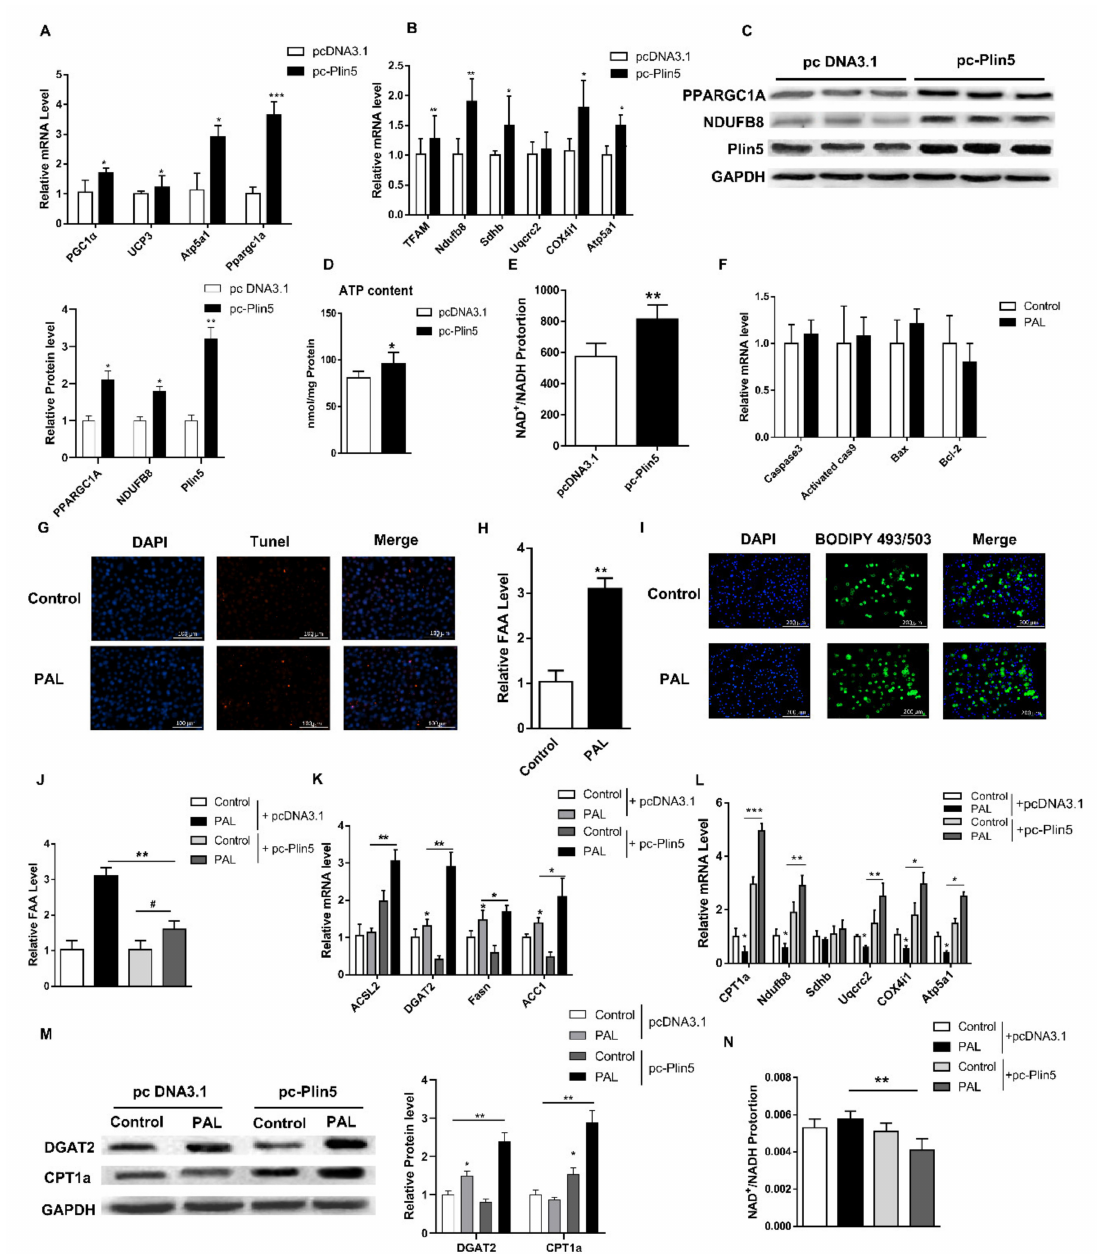
Figure 6. Plin5 promotes lipid synthesis and enhances mitochondrial β -oxidation in a lipotoxic model. ( A , B ) Real-time quantitative PCR was used to detect mitochondrial functional gene and β -oxidation gene mRNA expression after Plin5 overexpression. ( C ) Under the same treatment as ( A , B ), the protein levels of differentially expressed genes were analyzed by Western blotting. ( D ) The kit detected the ATP content of porcine adipocytes transfected with Plin5 overexpression vector. ( E ) The ratio of NAD + /NADH was measured after Plin5 overexpression in porcine adipocytes in vitro. ( F ) 0.4 mmol/L PAL treated porcine adipocytes in vitro for 48 h to detect the mRNA expression of apoptosis-related genes. ( G ) Porcine adipocytes in vitro were treated with 0.4 mmol/L PAL for 48h to perform Tunel staining. ( H ) The FFA level was detected by the kit after treatment of 0.4 mmol/L PAL with porcine adipocytes in vitro for 48 h. ( I ) BODIPY staining after the same treatment in vitro. ( J ) After Plin5 overexpression, 0.4 mmol/L PAL was used to treat porcine adipocytes in vitro for 48 h to detect FFA levels. ( K , L ) After Plin5 was overexpressed, pig adipocytes in vitro were treated with 0.4 mmol/L PAL for 48 h to detect the mRNA levels of lipid synthesis genes and mitochondrial β -oxidation genes. ( M ) Under the same treatment as ( K , L ), the protein levels of GDAT2 and CPT1a were analyzed by Western blotting. ( N ) The NAD + /NADH ratio is measured after the same treatment as ( J ). n = 4 for each group of cell samples, values are means ± SD. vs. control group, * p < 0.05, ** p < 0.01, *** p <